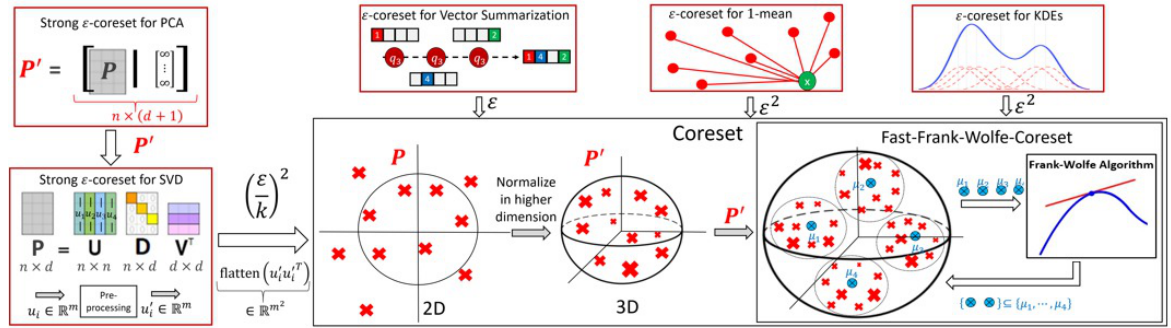
Figure 1. Illustration of Algorithm 2, its normalization of the input, its main applications (red boxes) and their plugged parameters. Algorithm 2 utilizes and boosts the run-time of the Frank–Wolfe algorithm for those applications; see Section